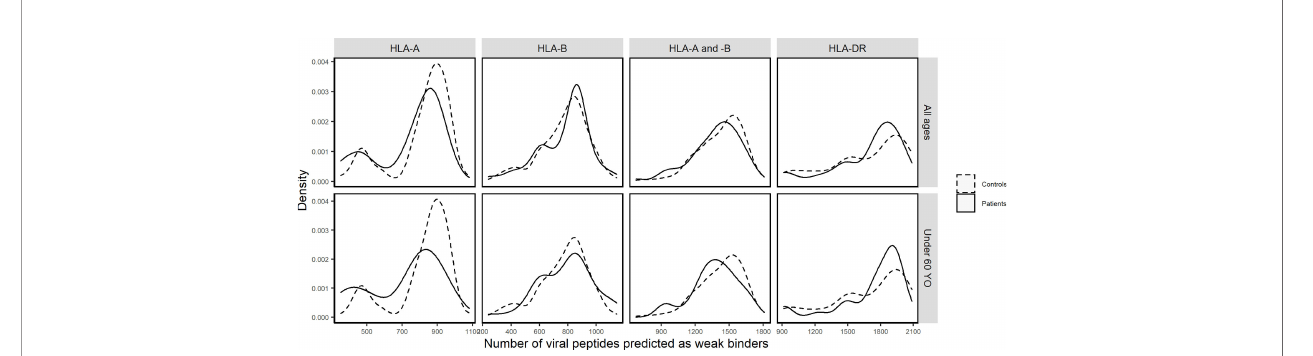
FIGURE 3 | Density distributions of the numbers of SARS-CoV-2-derived peptides predicted by %Rank as weak binders to HLA-A (n A ), HLA-B (n B ), HLA-A and -B (n AB ), and HLA-DR (n DR ) molecules in patients (solid curves) and controls (dashed curves) of all ages and in those under 60 years old,